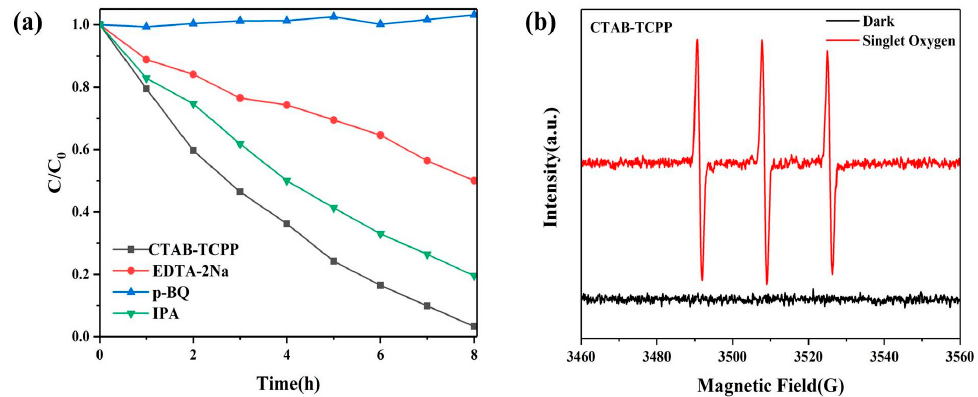
Figure 13. ( a ) Trapping experiments of reactive species by CTAB-TCPP aggregates ( b ) ESR spectra upon visible light irradiation of CTAB-TCPP aggregates for detection of 1 O 2.